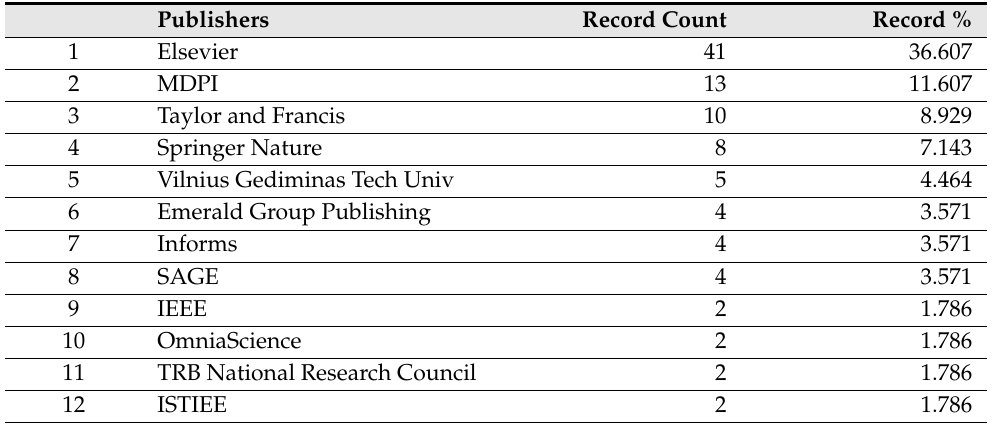
Table 6. Top publishing publishers out of